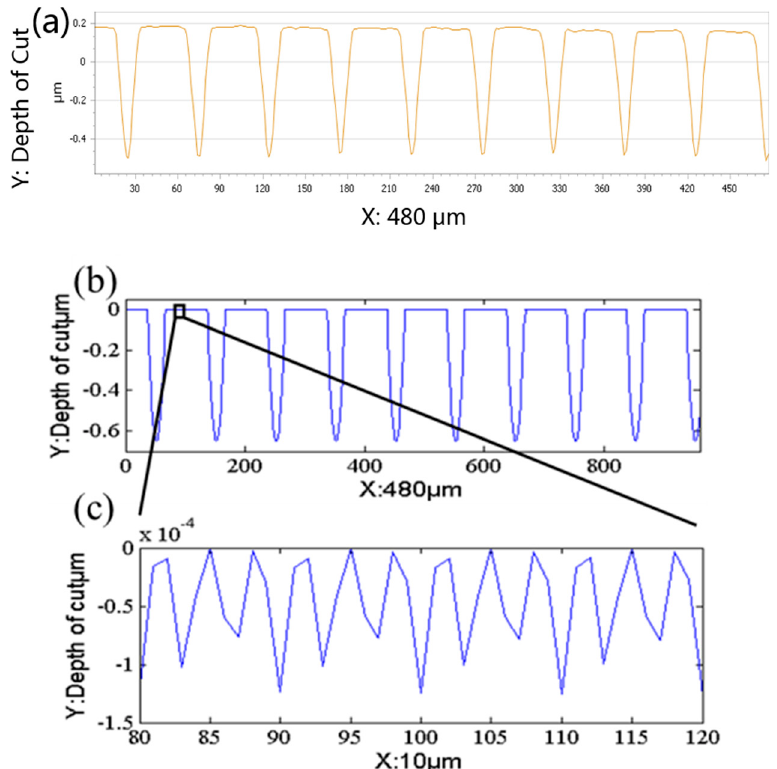
Figure 10. Comparison between the model and machining performance of the polar microstructure ( a ) Sectional view to show the structure space and depth of cut measured by Zygo, ( b ) The structure space and depth of cut simulated by surface topography model, ( c ) Enlarged sectional view of ( b ). Table 3. Experimental parameters influencing the machining quality of the polar microstructure and relevant simulated results.